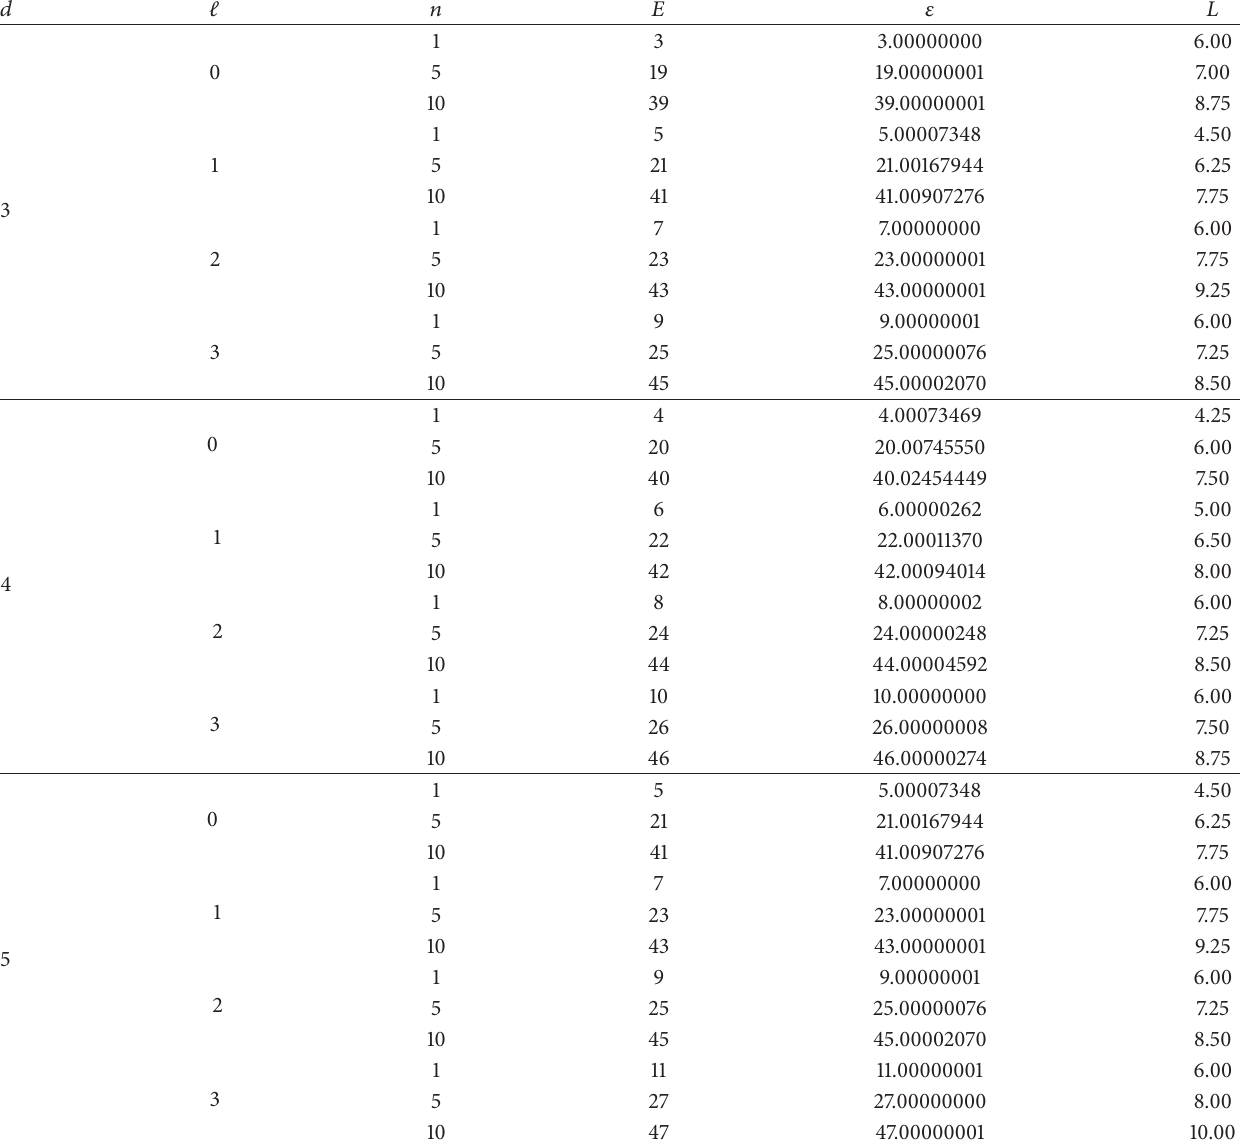
Table 3: Approximation of the energy levels of the harmonic oscillator in dimensions 𝑑 = 3, 4,5 . 𝑛 represents the energy state, 𝐸 is the exact solution for the energy given by (12), and 𝜀 is the upper bound to 𝐸 obtained using the present variational analysis. The eigenvalues 𝜀 𝑛 of H are minimized over 𝐿